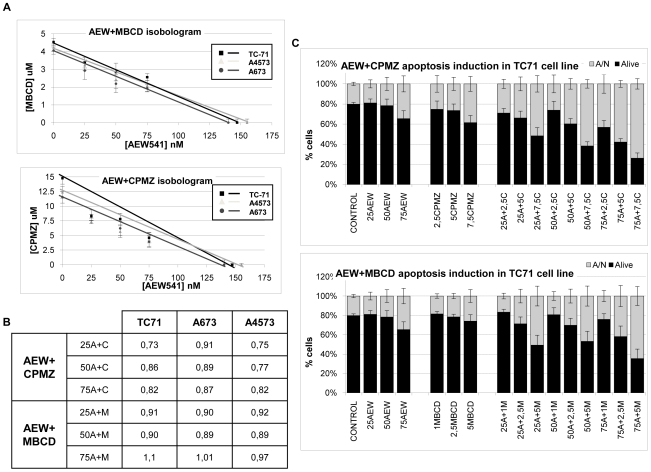
Effects of IGF1R tyrosine kinase inhibition combined with CAV1 or clathrin inhibition on ES cell proliferation and apoptosis.
A) Isobolograms of AEW combined with MCD/CPMZ. B) Combination index (CI) of AEW combined with MCD/CPMZ. AEW combined with MCD shows additive effects in the inhibition of ES cell line proliferation (CI around 1). In contrast, regarding AEW combined with CPMZ the effects were synergistic (CI between 0.73–0.86) in the A4573 and TC71 cell lines, and only additive in the A673 cell line. C) AEW combined with MCD/CPMZ had additive effects on the induction of apoptosis in ES cell lines, mainly inducing late apoptosis, with few cells undergoing necrosis. A: AEW, C: CPMZ and M: MCD. Data presented as the average of 4–6 independent replicates.